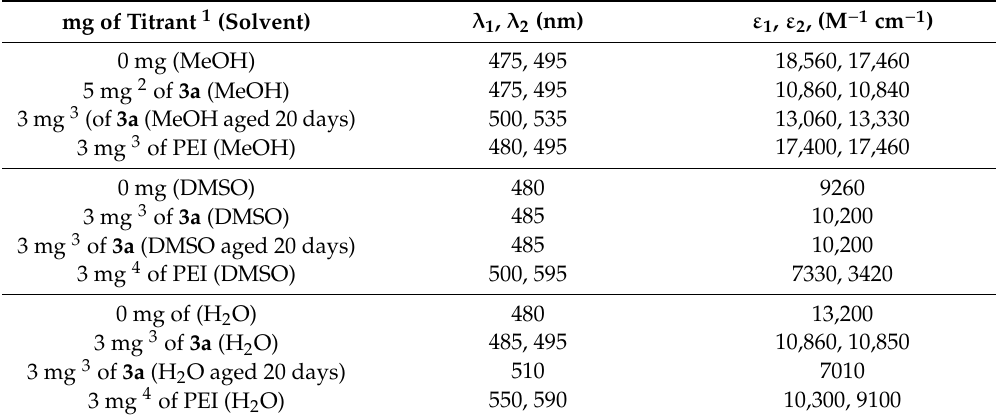
Table 1. UV-vis absorption maxima of 2.9 × 10 − 5 M Doxorubicin pure solutions and titrated in MeOH, DMSO, and H 2